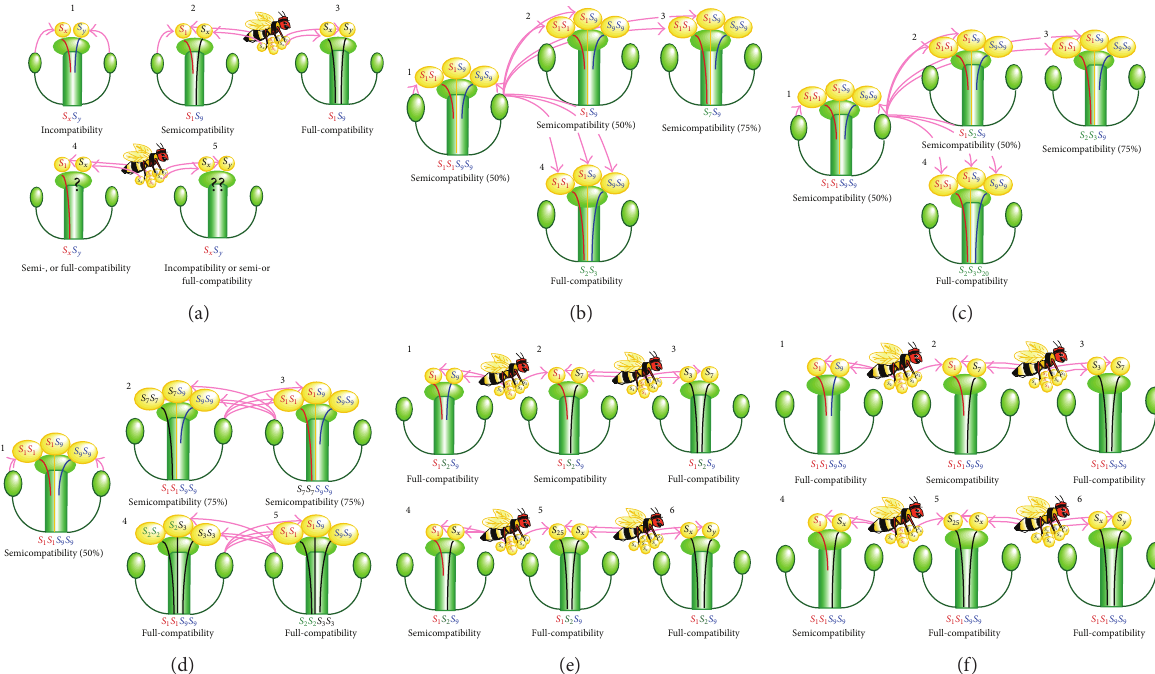
Figure 4: (a) Results of self-pollination of diploid “Dolgo” (1), diploid “Fuji” × diploid “Cox”s Pomona’ (2), “Fuji” × “Dolgo” (3), “Dolgo” × “Cox”s Pomona’ (4), and “Dolgo” × diploid “Pink Perfection” (5). (b) Results of self-pollination of tetraploid “Tensei” (1), diploid “Fuji” × “Tensei” (2), diploid “Jonathan” × “Tensei” (3), and diploid “Golden Delicious” × “Tensei” (4). (c) Results of self-pollination of tetraploid “Tensei” (1), triploid “Fukunishiki” × “Tensei” (2), triploid “Jonagold” × “Tensei” (3), and triploid “Mutsu” × “Tensei” (4). (d) Results of self-pollination of tetraploid “Tensei” (1), “Tensei” × tetraploid “Welday Jonathan” (2), “Welday Jonathan” × “Tensei” (3), “Tensei” × tetraploid “Doud Golden Delicious” (4), and “Doud Golden Delicious” × “Tensei” (5). (e) Results of triploid “Fukunishiki” × diploid “Fuji” (1), “Fukunishiki” × diploid “Shinano Sweet” (2), “Fukunishiki” × diploid “Tsugaru” (3), “Fukunishiki” × diploid “Cox”s Pomona’ (4), “Fukunishiki” × diploid“Snowdrift”(5),and“Fukunishiki” × diploid“Dolgo”(6).(f)Resultsoftetraploid“Tensei” × diploid“Fuji”(1),“Tensei” × diploid “Shinano Sweet” (2), “Tensei” × diploid “Tsugaru” (3), “Tensei” × diploid “Cox”s Pomona’ (4), “Tensei” × diploid “Snowdrift” (5), and “Tensei” × diploid “Dolgo”